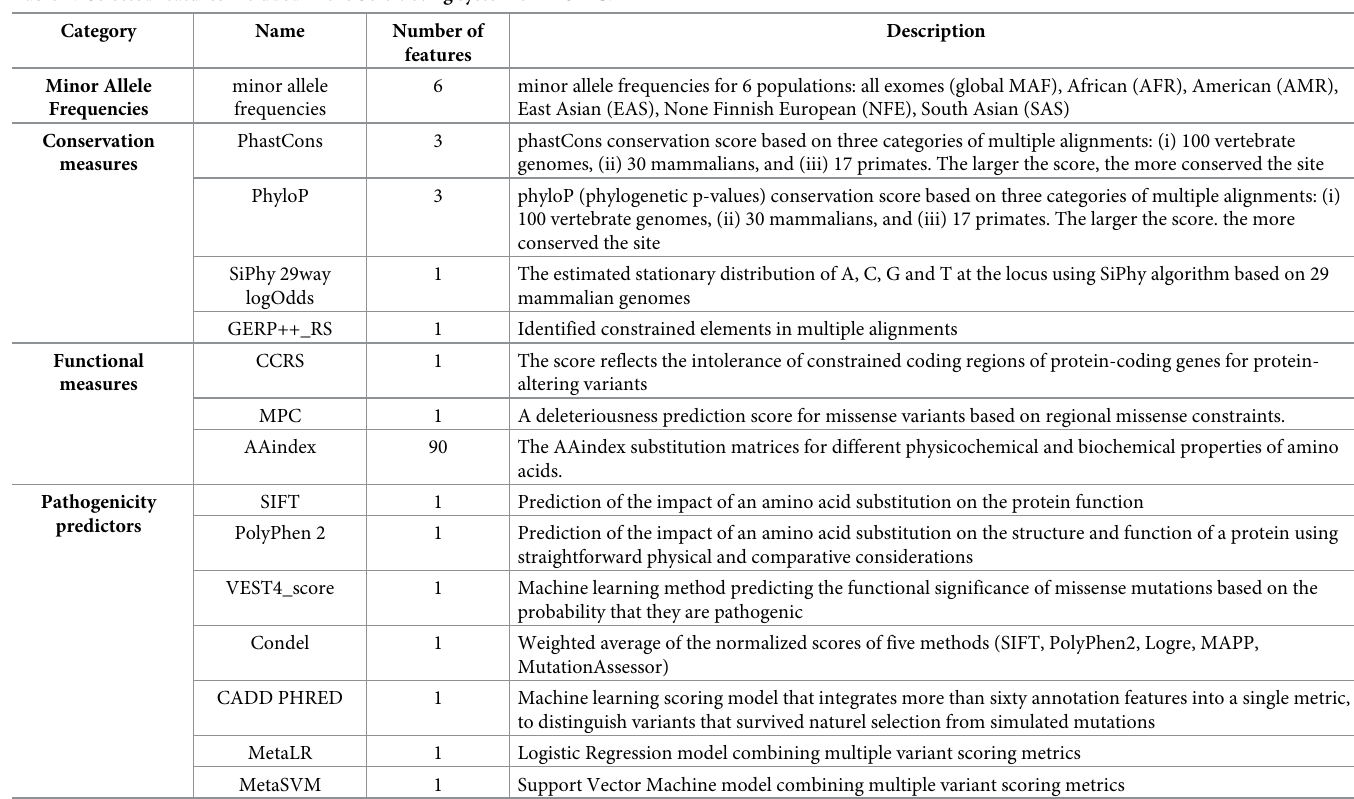
Table 1. Selected features included in the Soft Voting system of